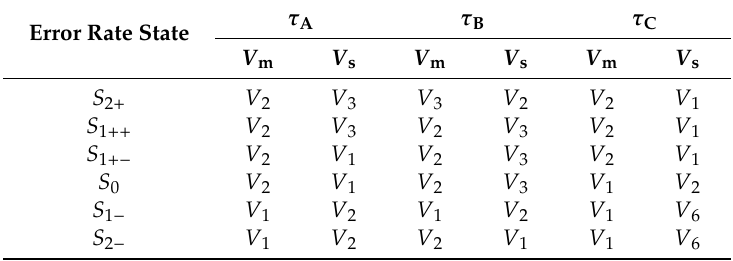
Table 4. Relationships among active factors and motor